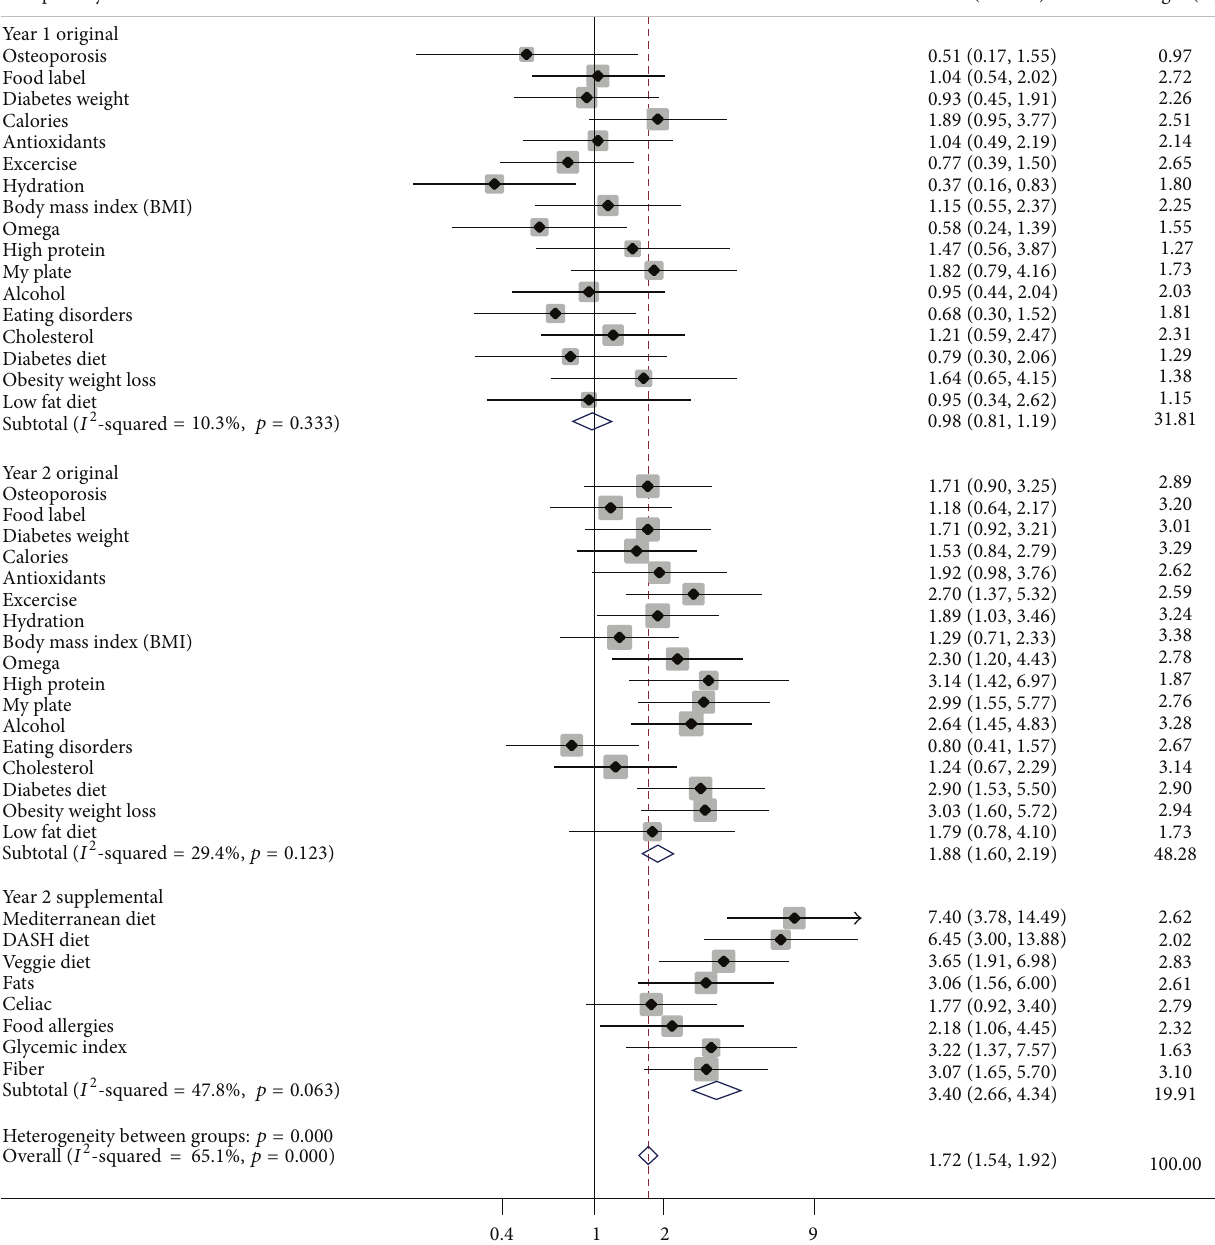
Figure 1: Pooled treatment effect of GCCM versus control on competencies using fully adjusted conditional multivariate logistic regression by year ( 𝑛 = 963 responses). Fully adjusted for gender, age, race, prior nutrition education, special diet, and clinical years’ upperclassman. GCCM, Goldring Center for Culinary Medicine; OR, odds ratio; CI, confidence interval. Statistical significance defined by either two-tailed 𝑝 value < 0.05 or ORs with 95% CIs not spanning